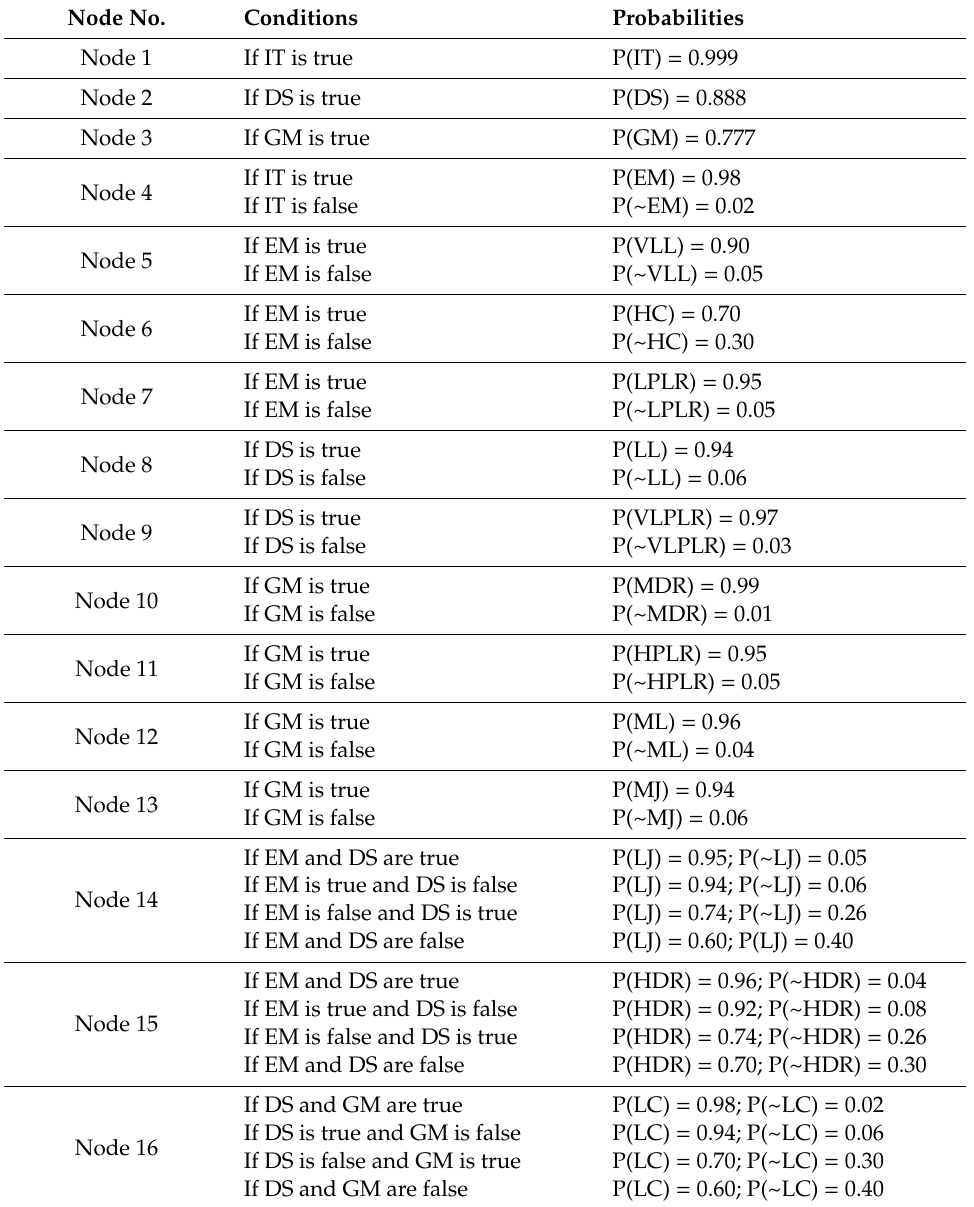
Table 1. Conditional probability table (CPT) for each node in the directed acyclic